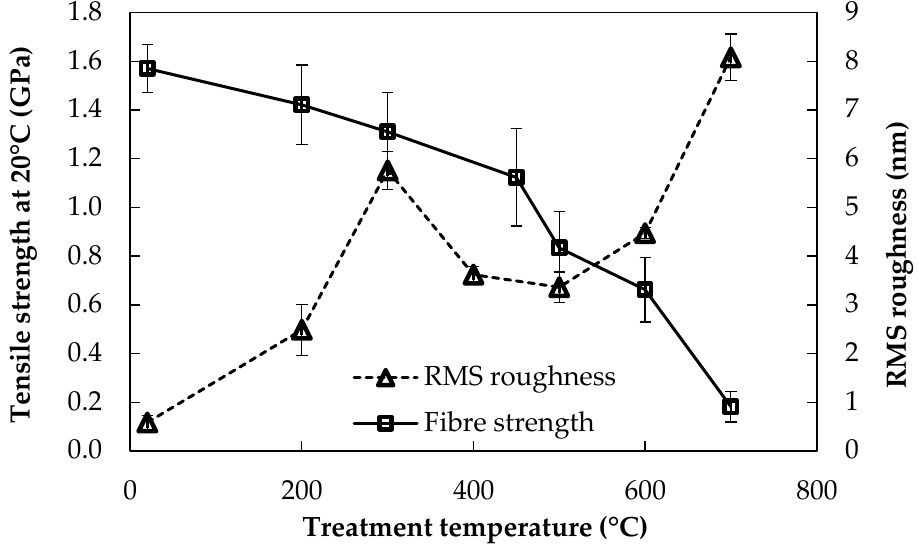
Figure 4. Average fibre tensile strength at room temperature, and fibre surface RMS roughness after thermal conditioning.